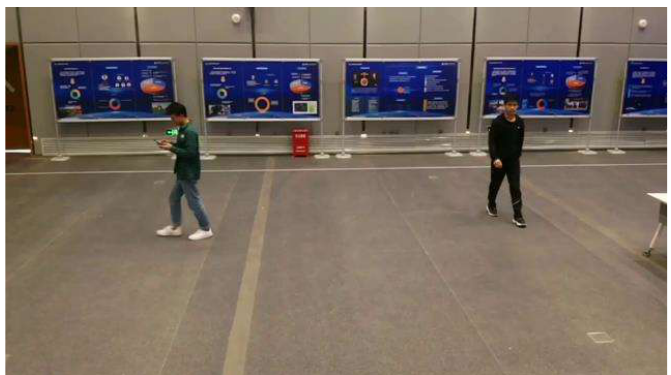
Figure 14. Experiment environment of combined detection based on color (left person: green clothes, right person: black clothes).